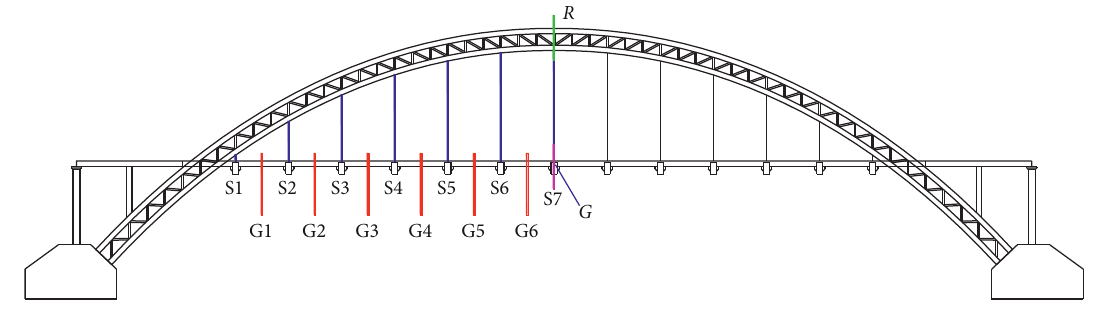
Figure 8: Signs of the components and